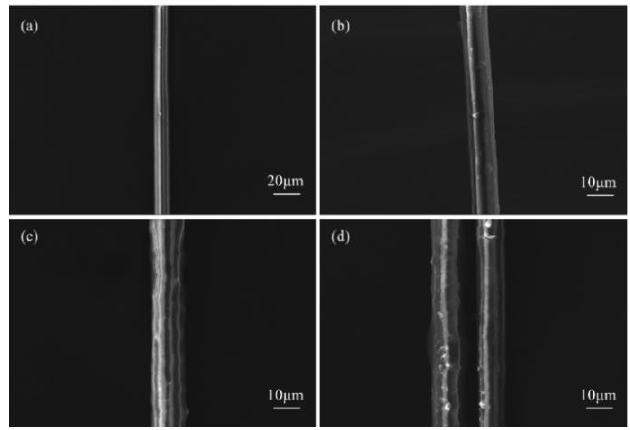
Figure 1. SEM of basalt fiber, ( a ) BF; ( b ) A-BF; ( c ) B-BF; ( d )